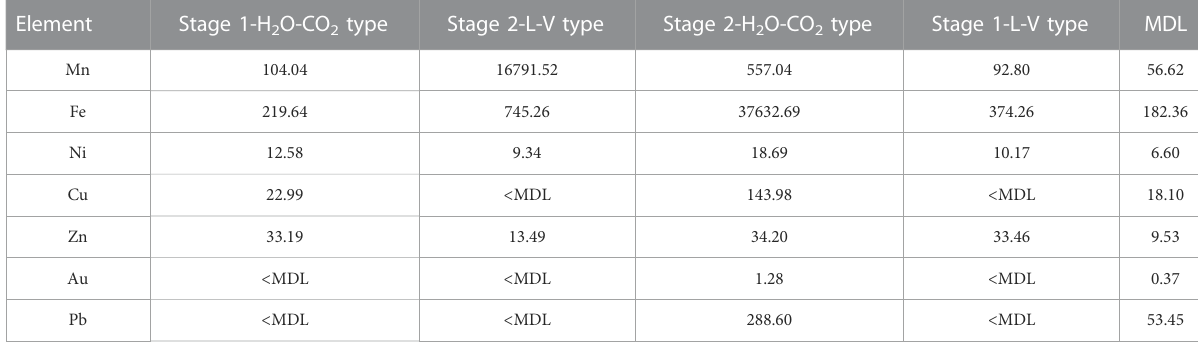
TABLE 3 SRXRF quantitative results of fl uid inclusions in quartz veins from the Dongtongyu gold deposit (ppm).